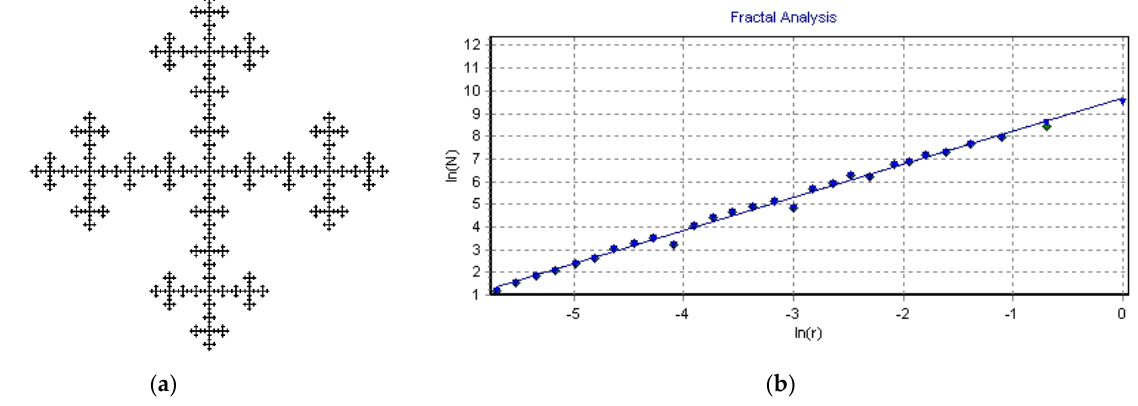
Figure 9. Determination of the fractal dimension: ( a ) Picture of Vicsek fractal; ( b ) Fractal dimension can be calculated as a slope from this linear log-log plot produced by HarFA software: log(N) = 1.463 × log(r).